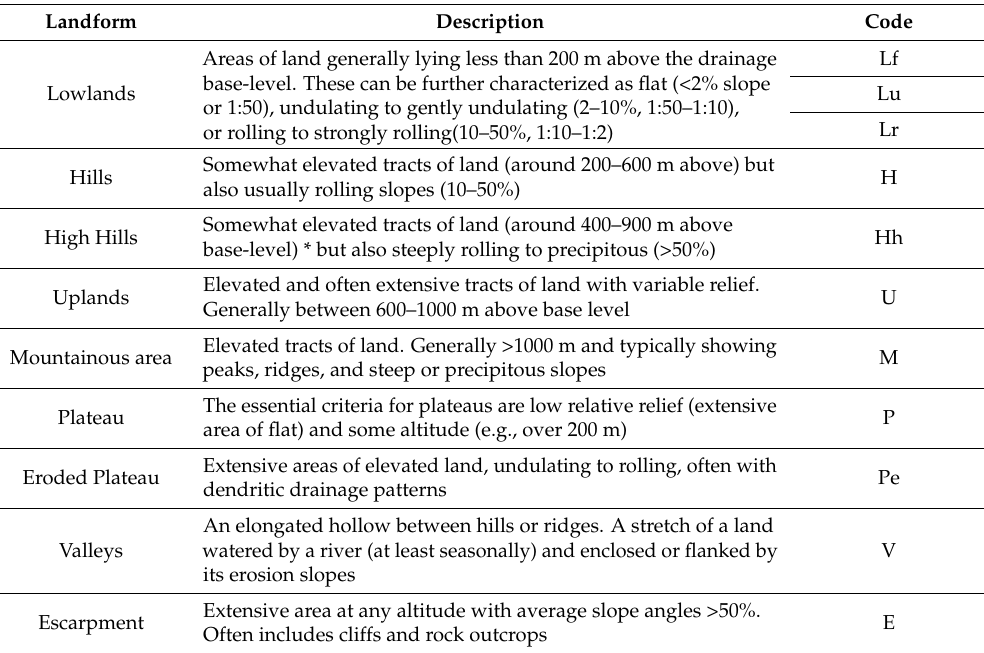
Table 1. Landforms, descriptions, and the code of each class.